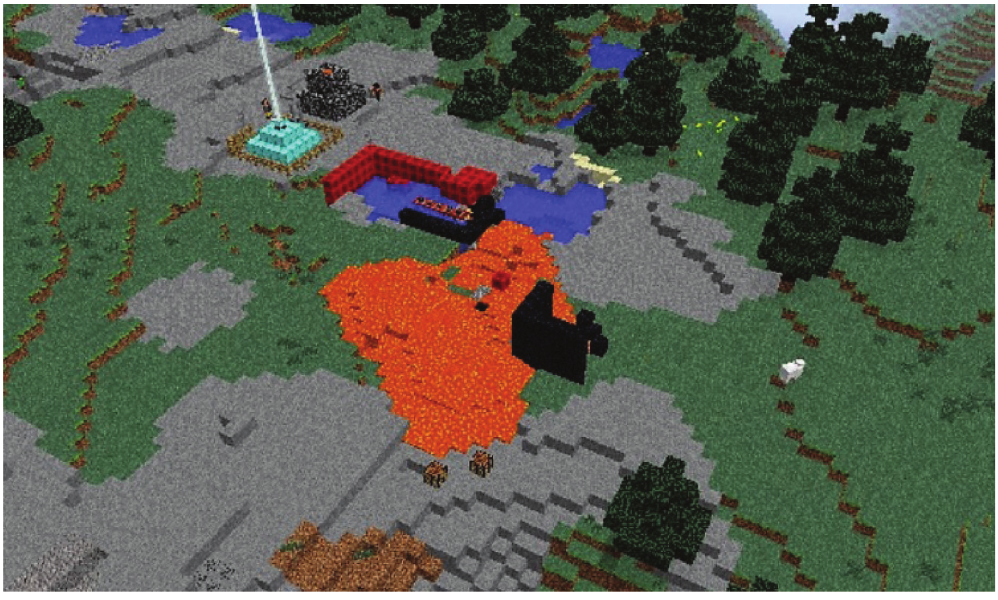
Figure 3: Lava (orange) from a volcano built during a Science Hunters Minecraft club session is prevented from reaching other constructions using walls (black) and water (blue) to impede its